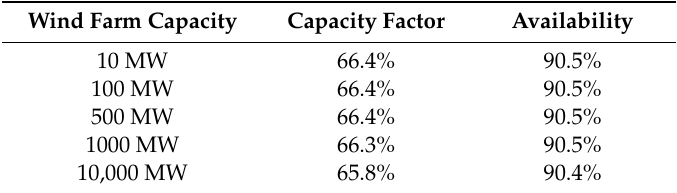
Table A4. Wind farms at Cape Mendocino ranging from 10 MW to 10 GW. The metrics do not significantly di ff er between farm